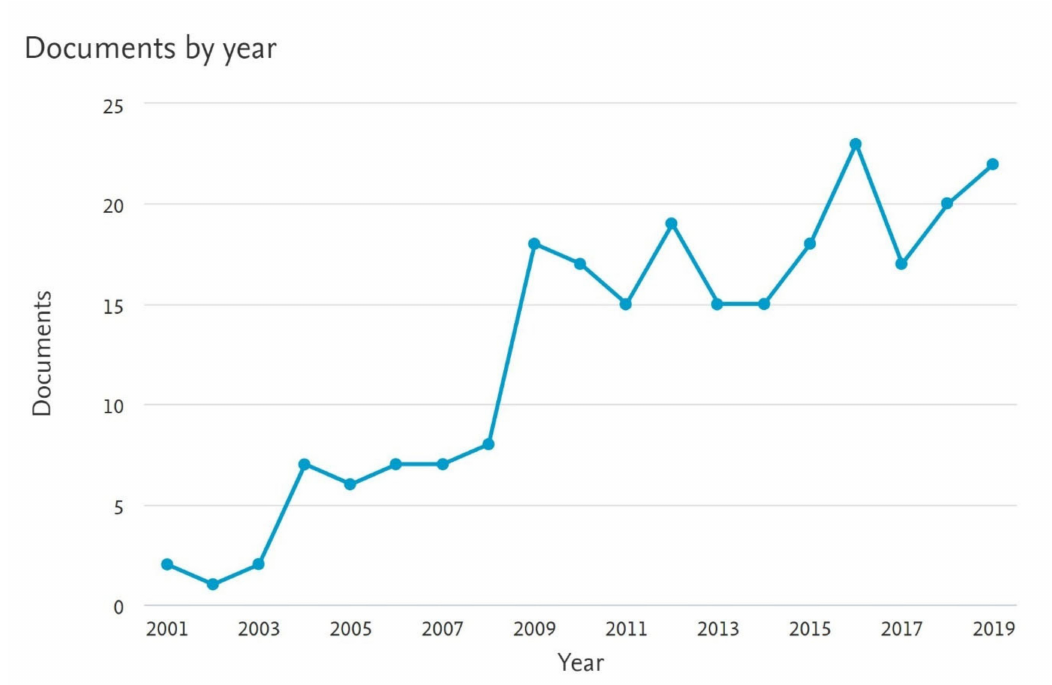
Figure 2. The graph illustrates the numbers of original articles on IRLs presence in MRI published annually, as indexed in Scopus (scopus.com); 2020 publications not included as not a full